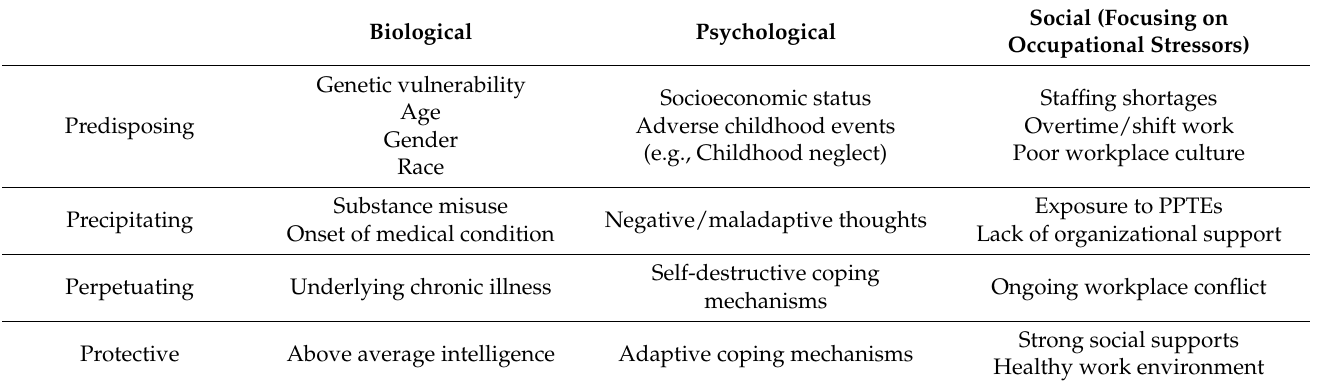
Table 1. Overview of the 4 Ps of the biopsychosocial